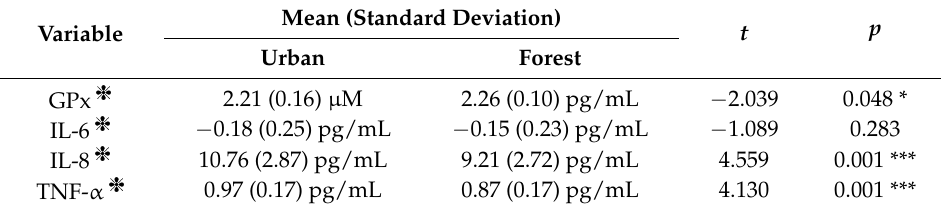
Table 4. Effect of exposure to forest environment on serum pro-inflammatory cytokine and GPx